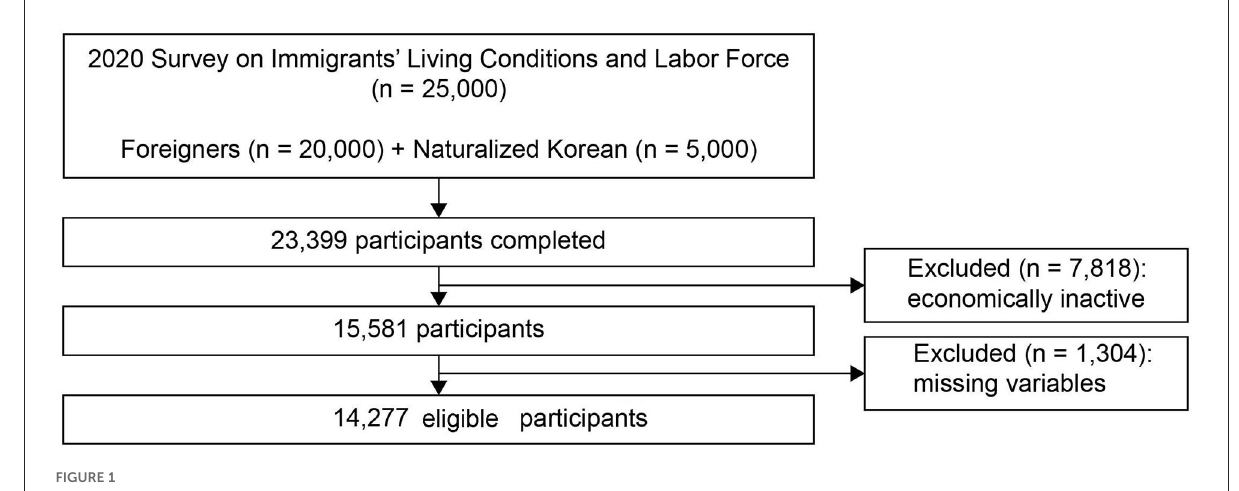
FIGURE1 Flowchart of study participants’ selection